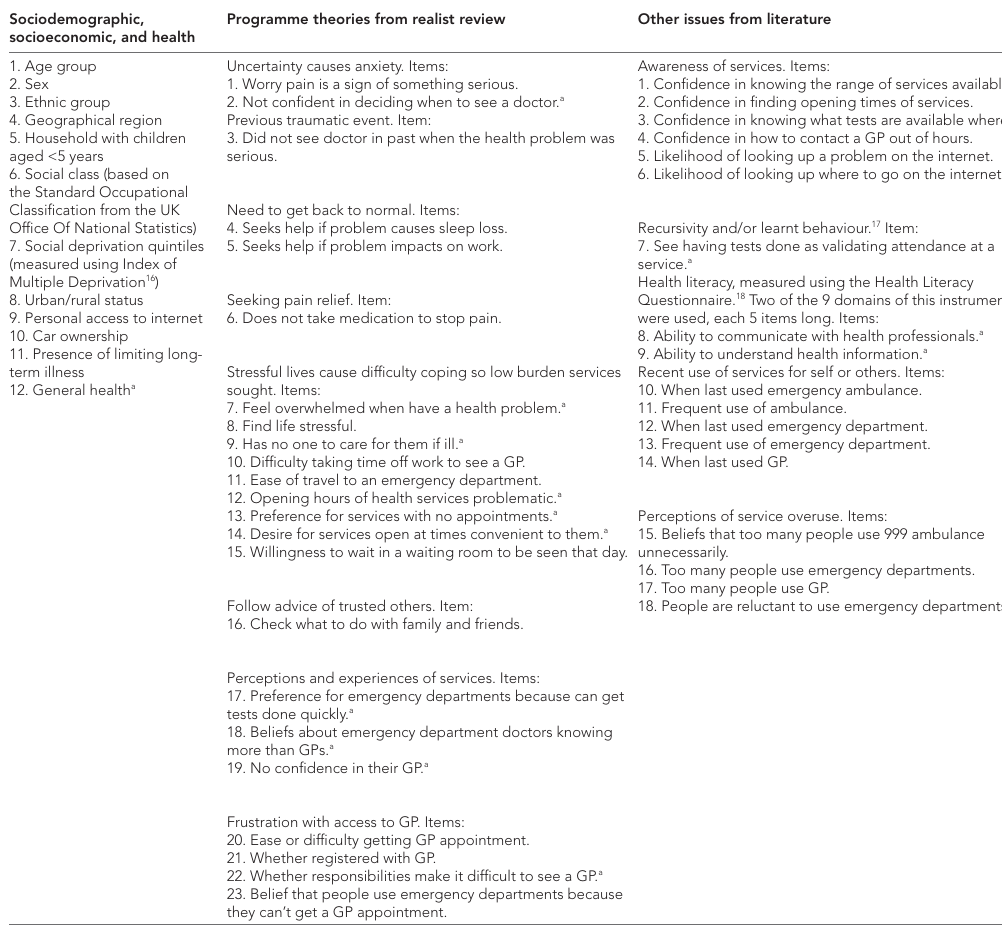
Table 1 Factors tested in the